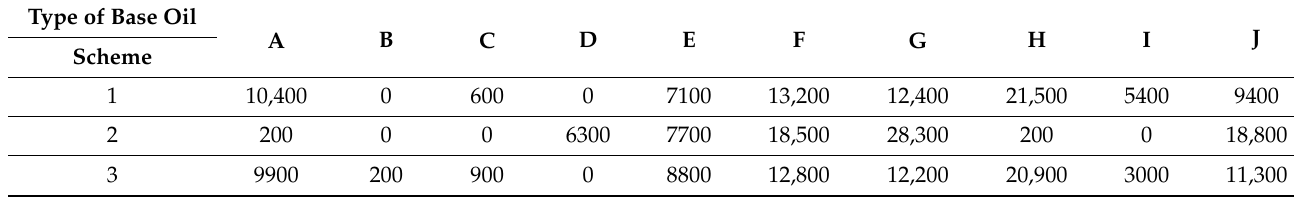
Table 5. Comparison of the three blending schemes of 80,000 tons (unit: